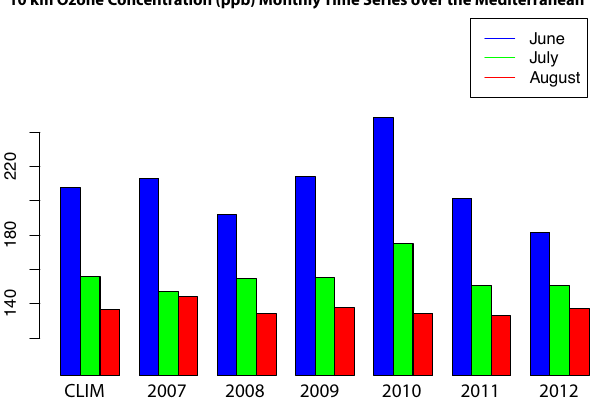
Figure 8. Same as Fig. 5 for 10km ozone concentrations measured by IASI.